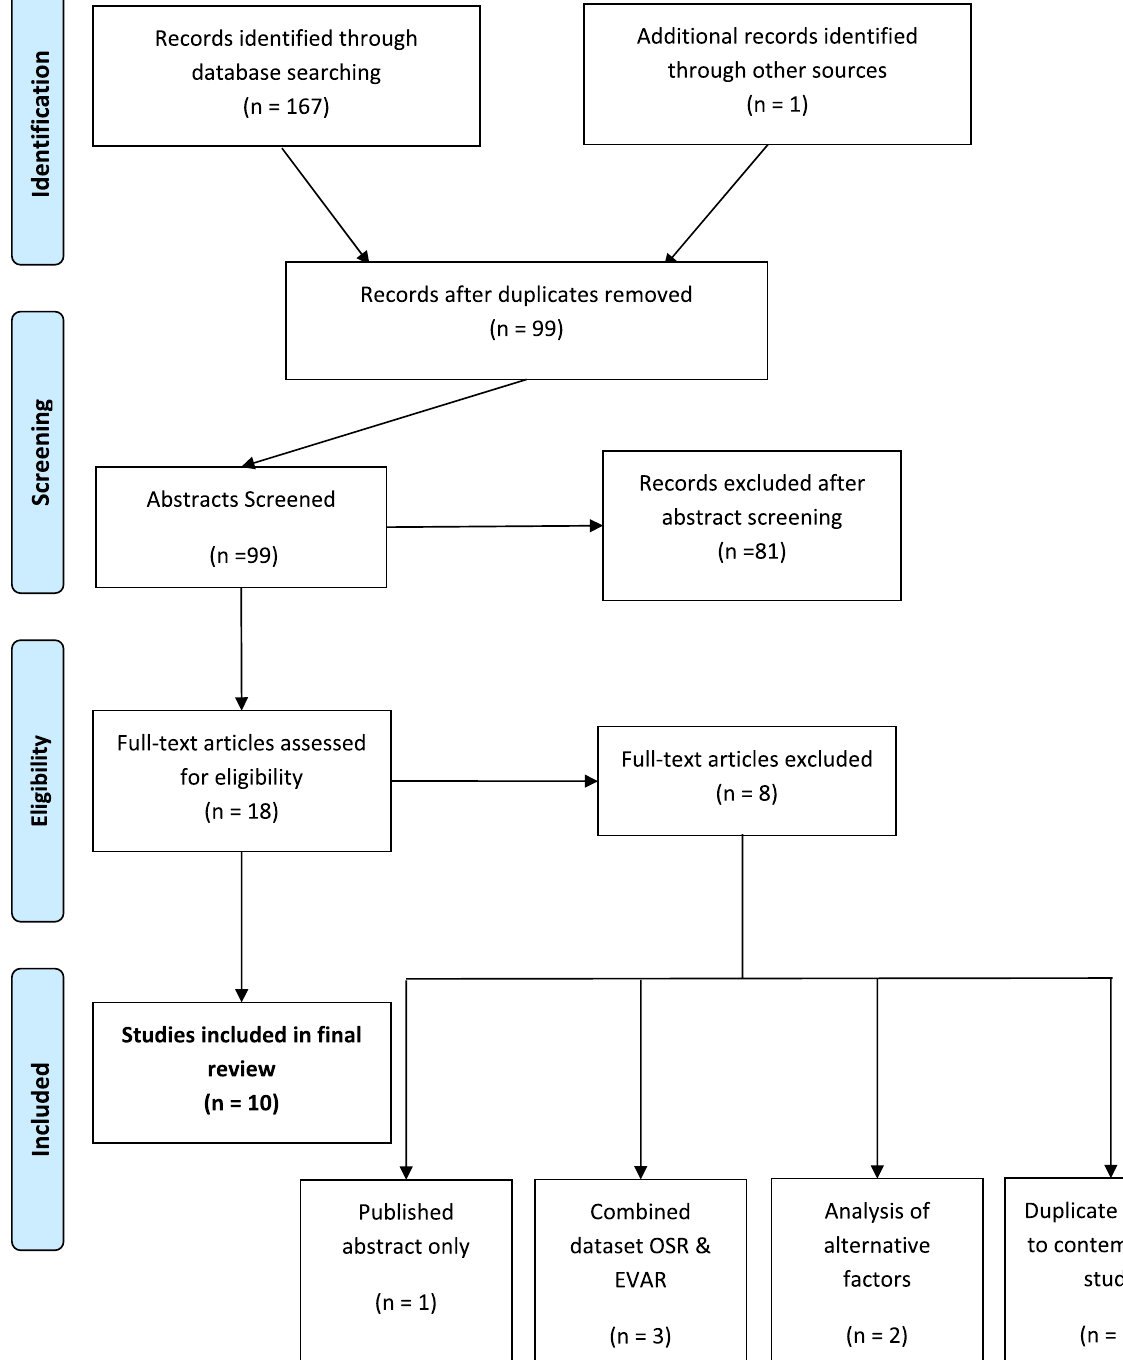
Figure 1. PRISMA diagram showing study inclusion. OSR (Open Surgical Repair), EVAR (Endovascular Aneurysm Repair), SMI (Skeletal Muscle Index), PMI (Psoas Muscle